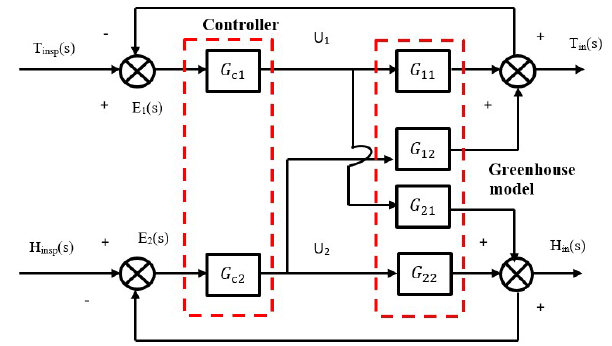
Figure 6. Illustration of Multi-Input Multi-Output Transfer Func- tion Model of Greenhouse.